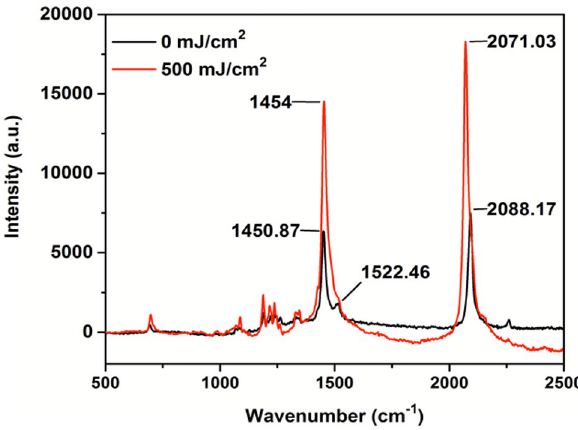
Figure 3. Raman spectra of DA 8 film dosimeter.